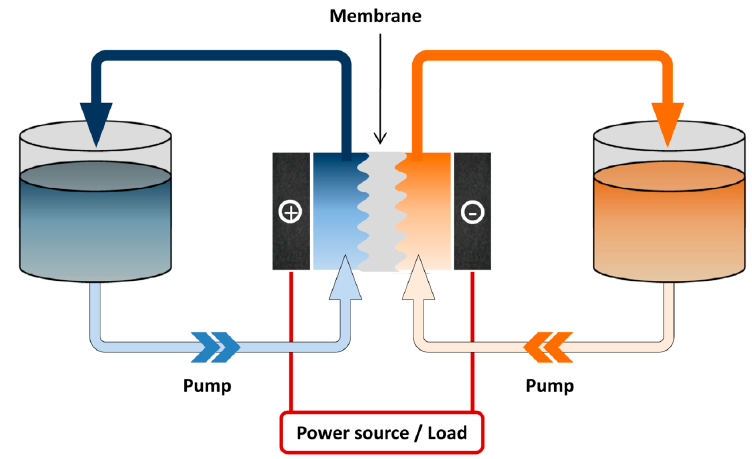
Figure 1. Schematic illustration of a redox flow battery. Active species are stored externally in the storage tanks, while the conversion between electrical and chemical energy occurs in the cell unit.